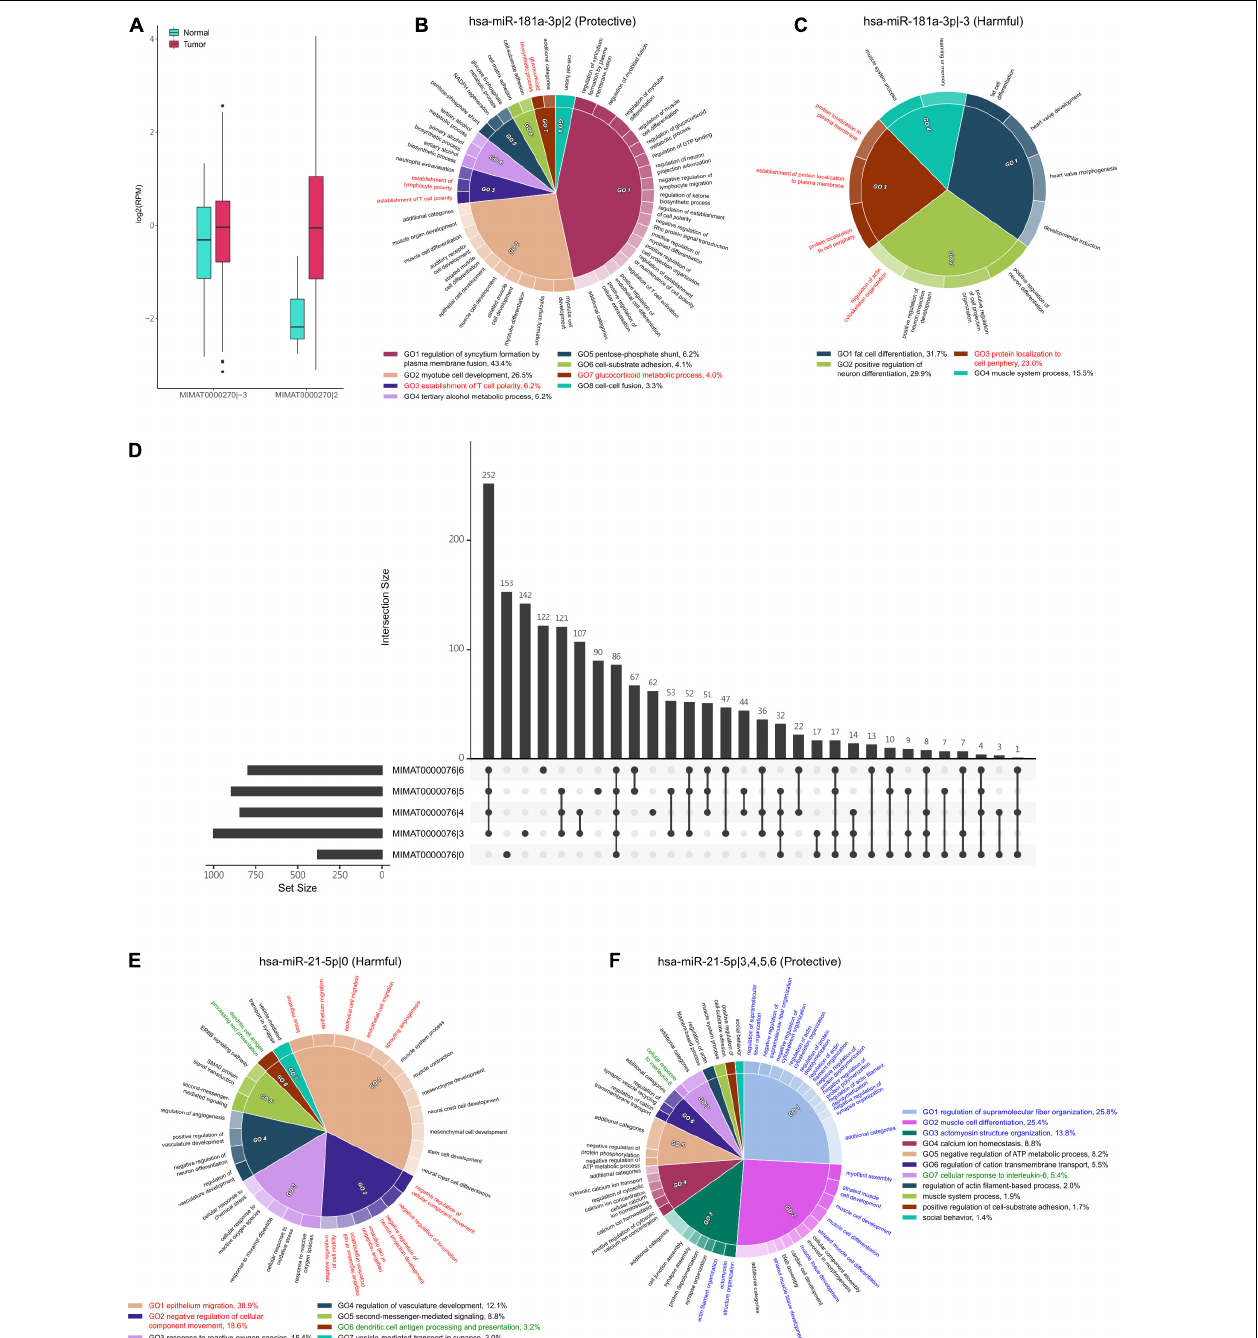
FIGURE 4 | The regulatory function of hsa-miR-181a-3p|-3 and hsa-miR-181a-3p|2. (A) The expression of (hsa-miR-181a-3p|-3) and (hsa-miR-181a-3p|2) in tumor and normal samples. Both are upregulated in tumor samples. (B,C) The significantly enriched functions in which the downregulated target genes of hsa-miR-181a-3p|2 (B) and hsa-miR-181a-3p|-3 (C) are involved. The percentage is the relative significance of one functional module to others. The functional modules associated with EMT are marked by red. (D) The intersection of downregulated target genes between the archetype of hsa-miR-21-5p and its four protective isomiRs. The horizontal bars on the left side show the numbers of downregulated target genes of corresponding isomiRs of hsa-miR-21-5p, while the vertical bars show the intersection number. The dot represents whether the set is part of the intersection. (E,F) The significantly enriched functions in which the downregulated target genes of hsa-miR-21-5p|0 (E) and hsa-miR-21-5p|3, 4, 5, and 6 (F) are involved. The percentage is the relative significance of one functional module to others. The functional modules associated with metastasis, regulation of immune response, and regulation of muscle development are marked by red, green, and blue,